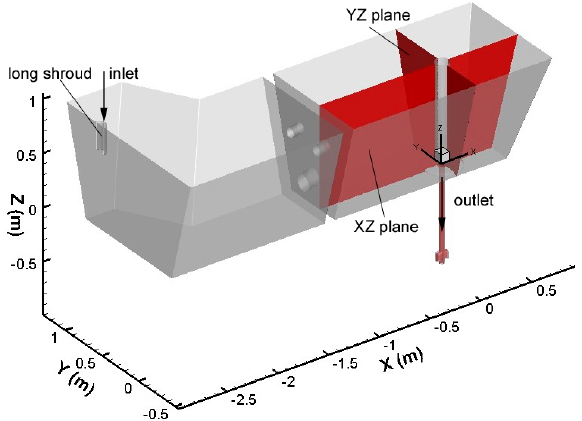
Figure 3. Schematic diagram of regional coordinate system of half tundish in the model